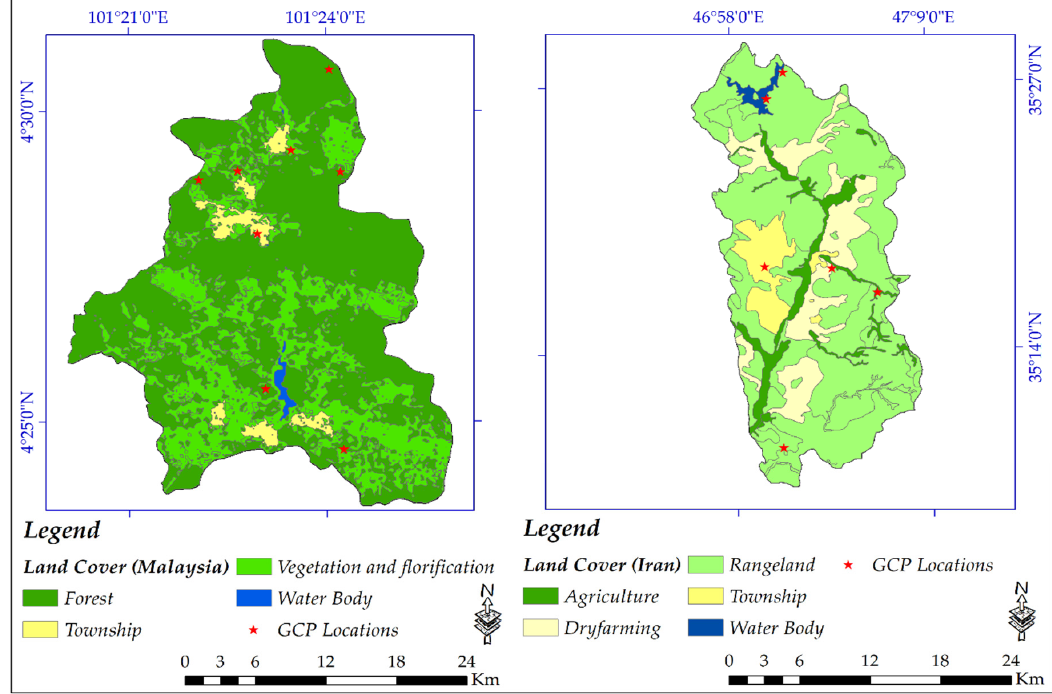
Figure 7. Geographical locations of the Ground Control Points (GCPs) on the land cover maps.